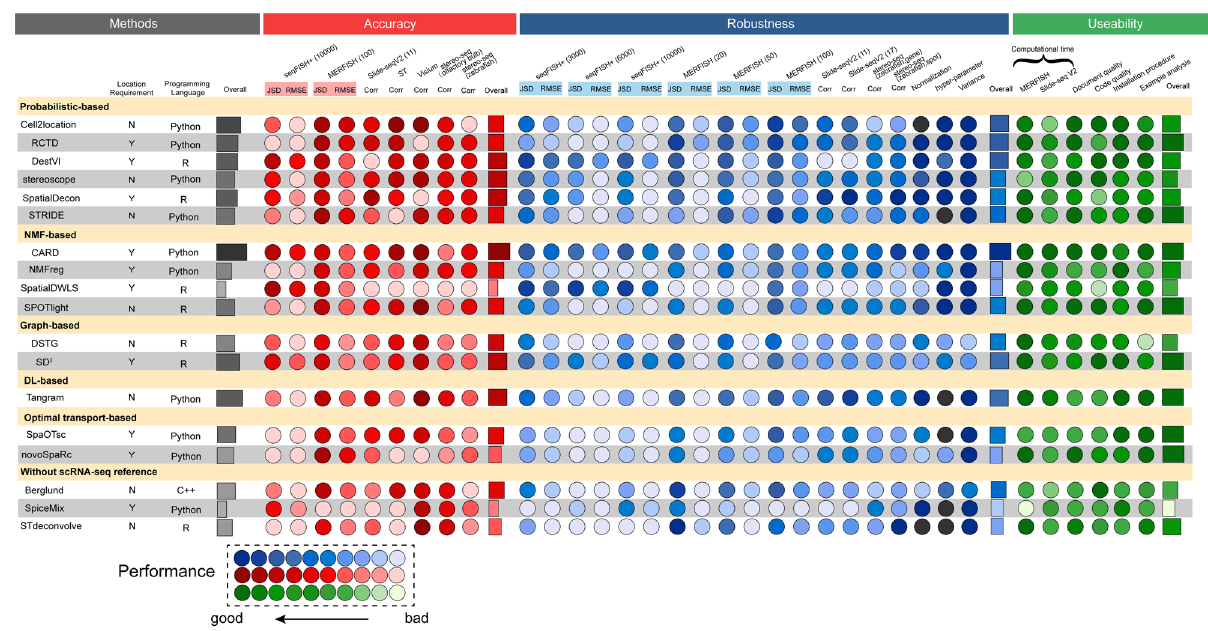
Fig. 2 | The summary table of the performance of all methods. We visualized their performance in terms of accuracy (red), robustness (blue), and usability (green), and we listed the requirement of spatial location, programming language, and the overall performance (gray) for each method. For all colored dots, a darker